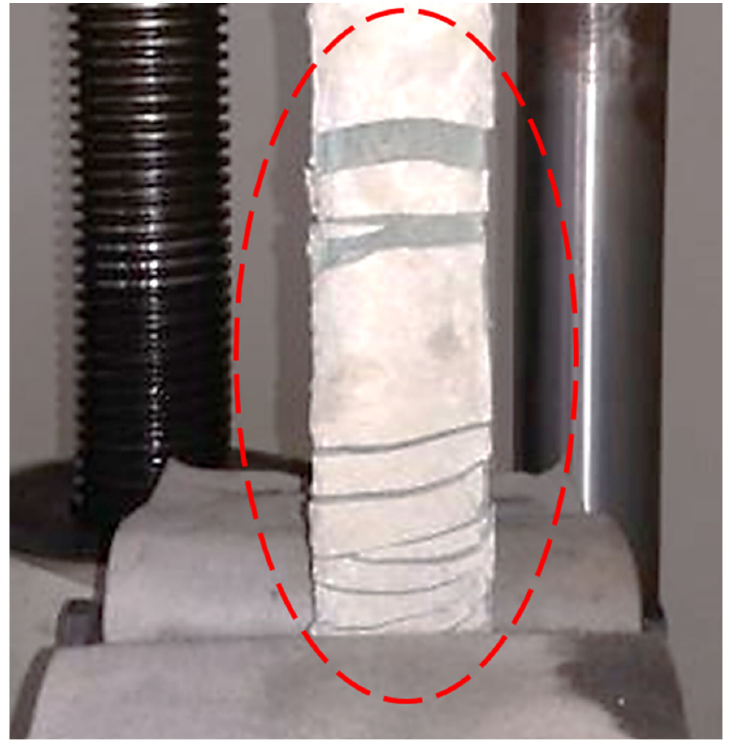
Figure 19. Crack pattern in tested TRM specimen (TRM2).